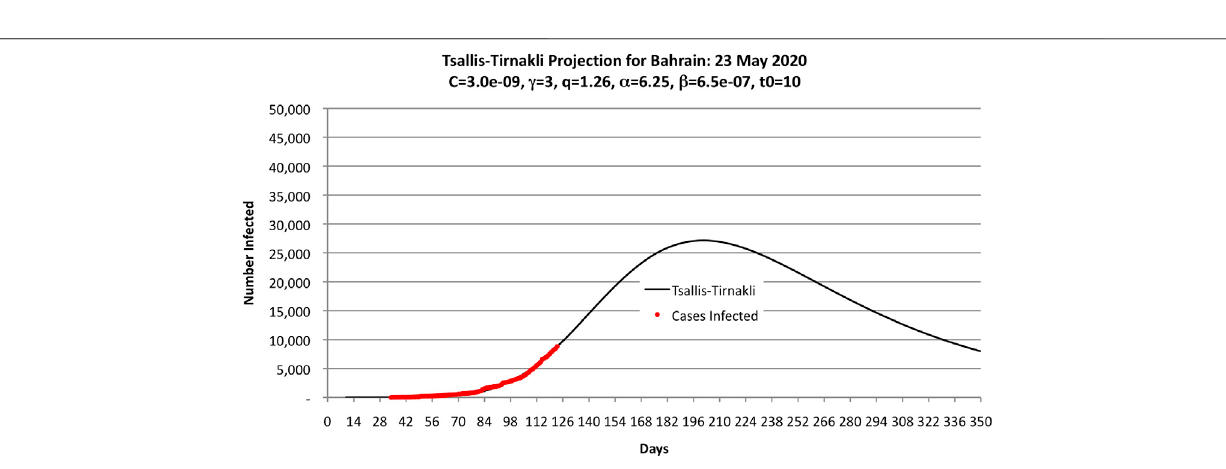
FIGURE2| Parametersusedbytheauthorsto fi ttheCOVID-19dataasof23May2020(shownasblackdots)totheTsallis-Tirnaklidistribution.Notethatthecurve predicts 33,000 cases.